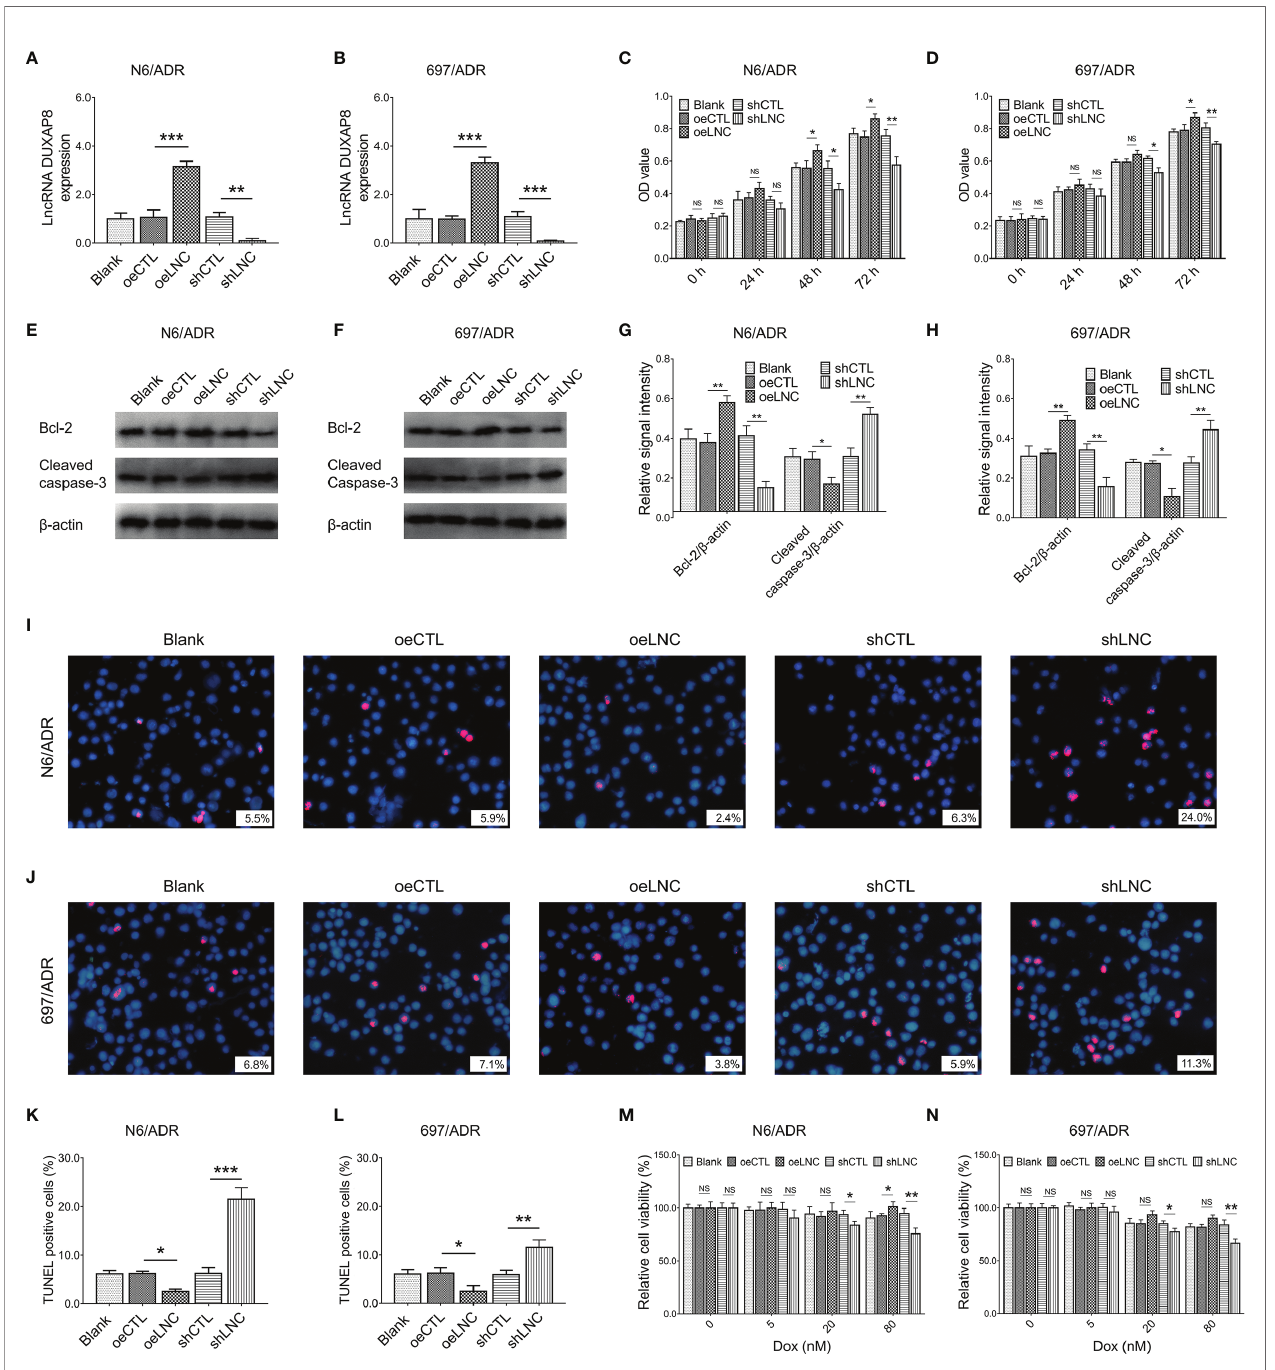
FIGURE 3 | Cell behaviors after lncRNA DUXAP8 modi fi cation. LncRNA DUXAP8 (A, B) , cell proliferation by CCK-8 (C, D) , apoptotic marker expressions (E – H) , cell apoptosis rate (I – L) , and chemosensitivity to Dox (M, N) among blank, oeCTL, oeLNC, shCTL, and shLNC groups in N6/ADR cells and 697/ADR